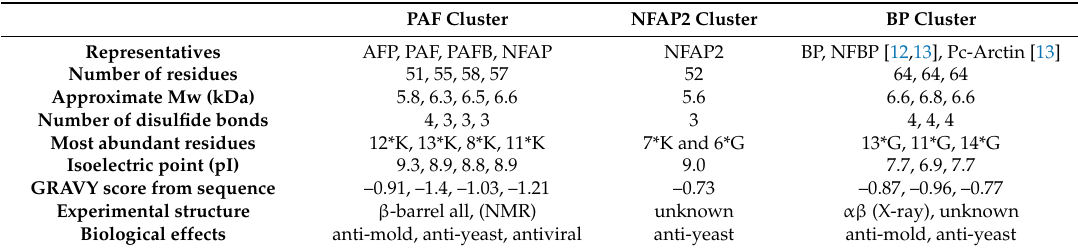
Table 1. Classification of antifungal β -strand, disulfide proteins. Mw and pI were calculated with ProtParam (https://web.expasy.org/cgi-bin/protparam/protparam). In residue statistics n*K and n*G stand for number of lysine and glycine residues. GRAVY hydropathy scores are calculated via (http://www.gravy-calculator.de). Lower GRAVY values mean less hydrophobic structures. NFBP is Neosartorya fischeri bubble protein